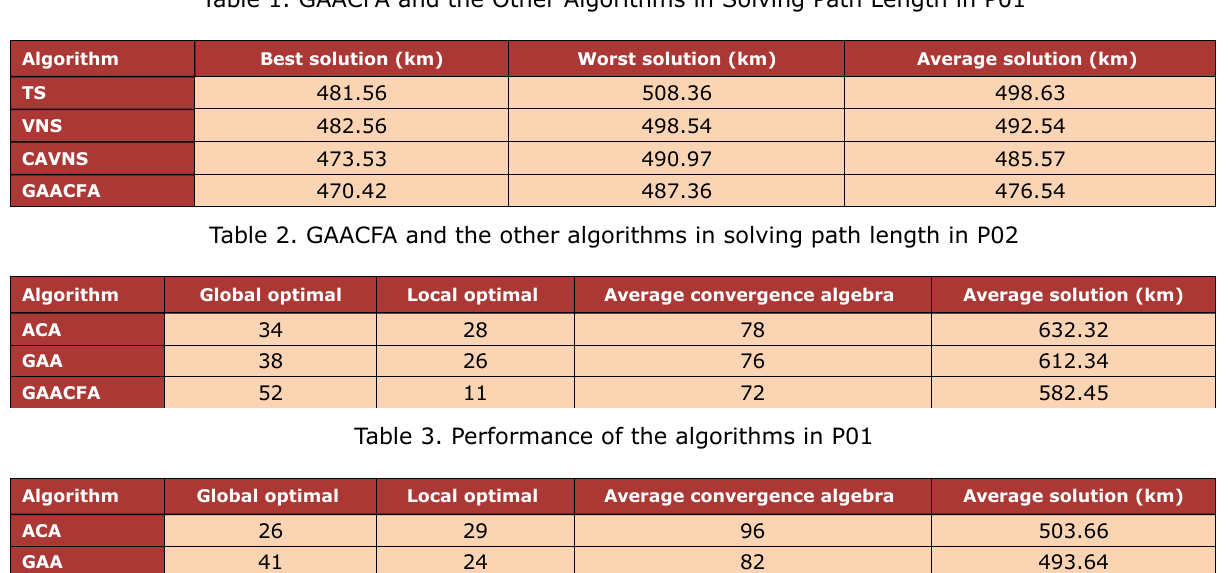
Table 1. GAACFA and the Other Algorithms in Solving Path Length in P01